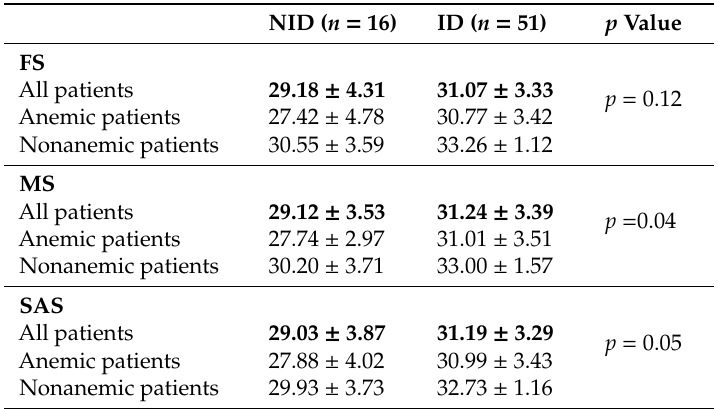
Table 2. Computed blue color assessment according to the delineation method.